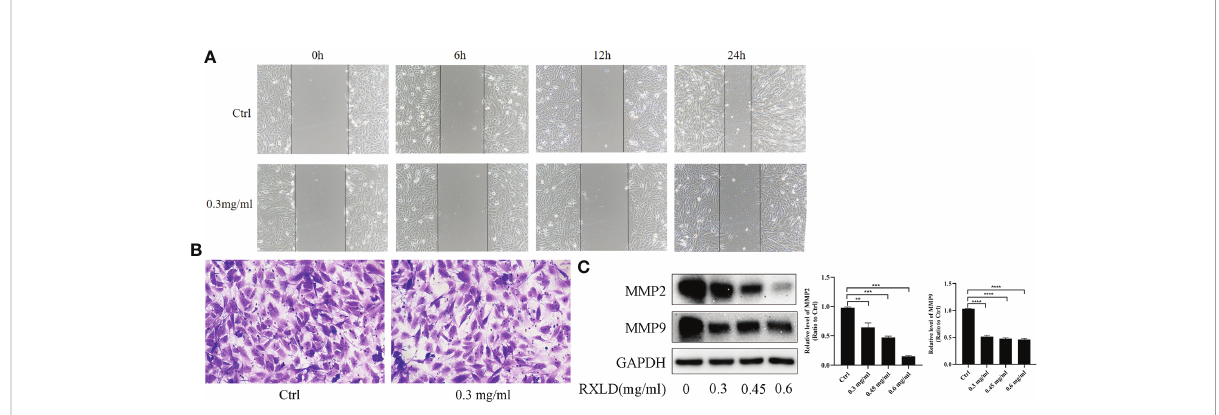
FIGURE 9 RXLD extracts affected the migration of GBM cells. (A) The wound healing assay was performed on the A172 cell line at 0, 6, 12, and 24 h after the cells were treated with RXLD extracts; (B) The cell migration results (transwell assay) of the A172 cell line that was treated with RXLD extracts for 48 h; (C) Western blotting results of the cell migration-related genes (MMP2, MMP9) expressed in A172 cells that were treated with RXLD extracts (0.3, 0.45, and 0.6 mg/ml) for 48 h. ** P<0.01, *** P<0.001, **** P<0.0001.